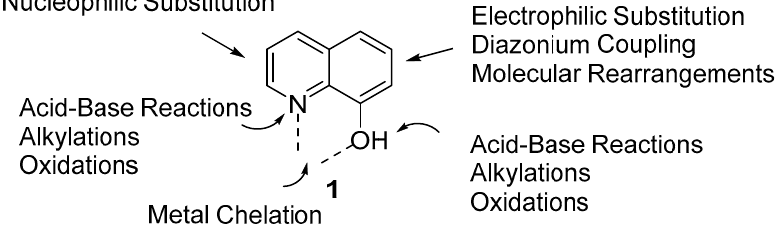
Figure 1. Reaction sites of 8-hydroxyquinoline 1 .